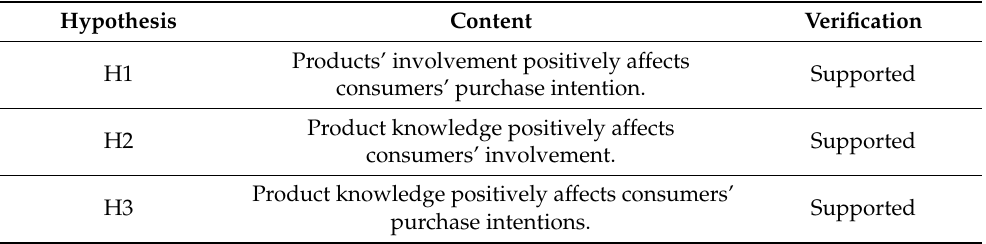
Table 2. Summary of hypothesis